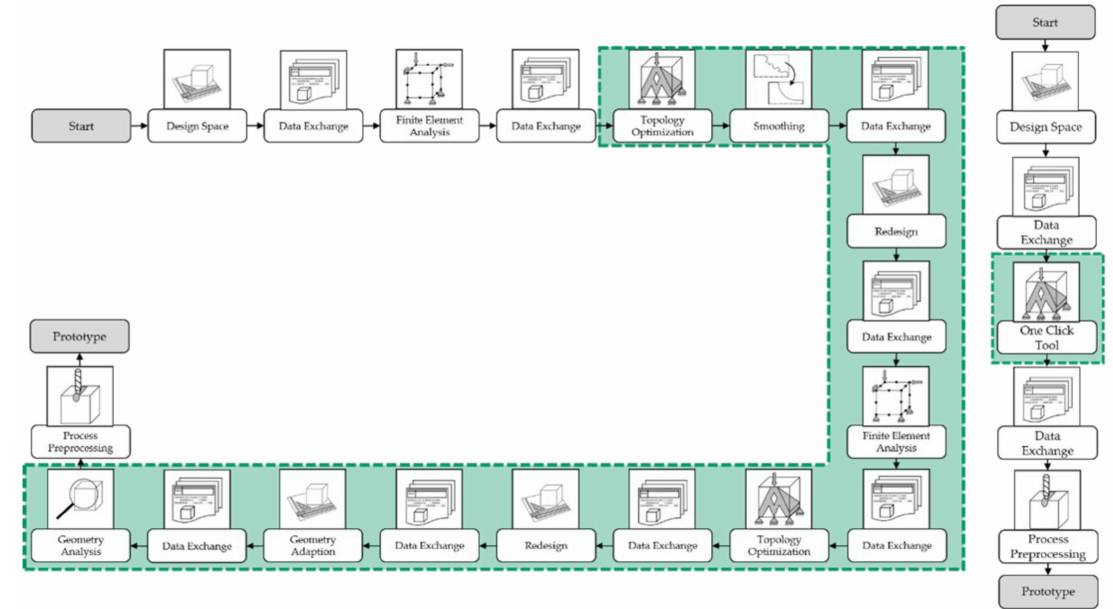
Figure 1. The visualization of the presented one-click optimization approach. The one-click tool aims to re-place and to widely automate the steps of topology optimization, smoothing, data exchange and redesign and finite element analysis, which are shown inside the green shaded